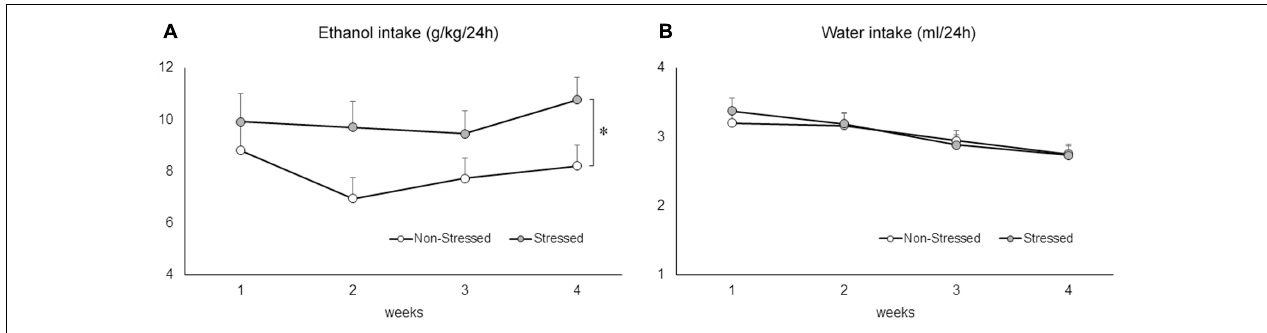
FIGURE 6 | (A) Ethanol (g/kg/24 h) and (B) water (ml/24 h) consumption in non-stressed controls and socially defeated mice 10 days after the last confrontation. Mice were exposed to continuous access to ethanol (20% weight/volume) and water for 4 weeks. Data are mean ± SEM. ∗ versus non-stressed controls. p < 0.05, n = 23 − 25 mice per